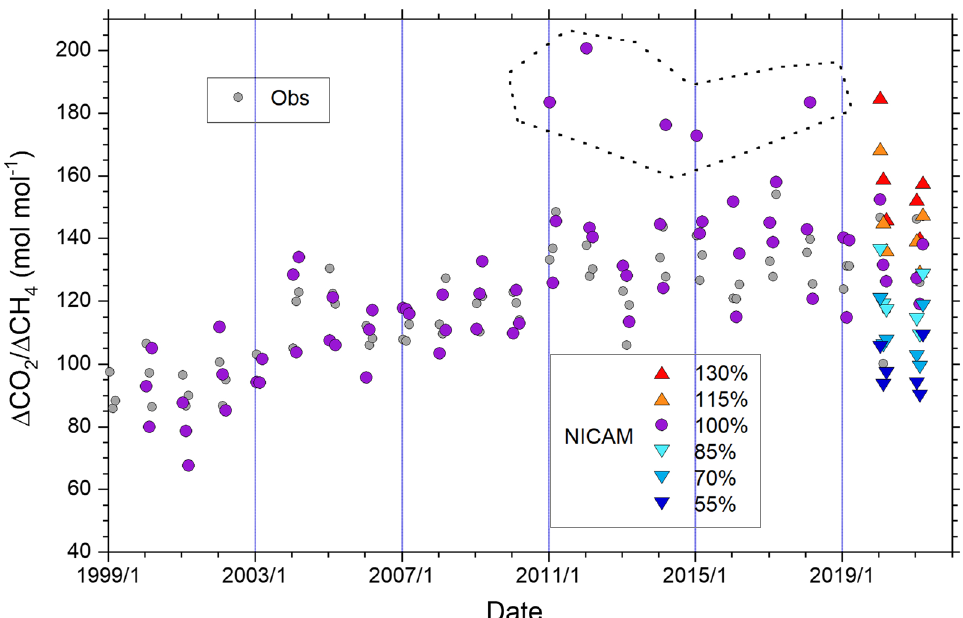
Fig. 5 Temporal change in the monthly ΔCO 2 /ΔCH 4 ratios during January–March from 2000 to 2021. The simulated monthly ΔCO 2 /ΔCH 4 ratios based on the FFCO 2 emissions of Set A are plotted as purple circles. The observed monthly ΔCO 2 /ΔCH 4 ratios at HAT are plotted as gray circles for comparison. The purple circles surrounded by the dotted line represent the outliers, which are more than 20 mol mol − 1 larger than the corresponding observed ratios. The color-coded triangles represent the simulated results based on the FFCO 2 emissions of Set B from 55 to 130% for the meteorological fields of 2020 and